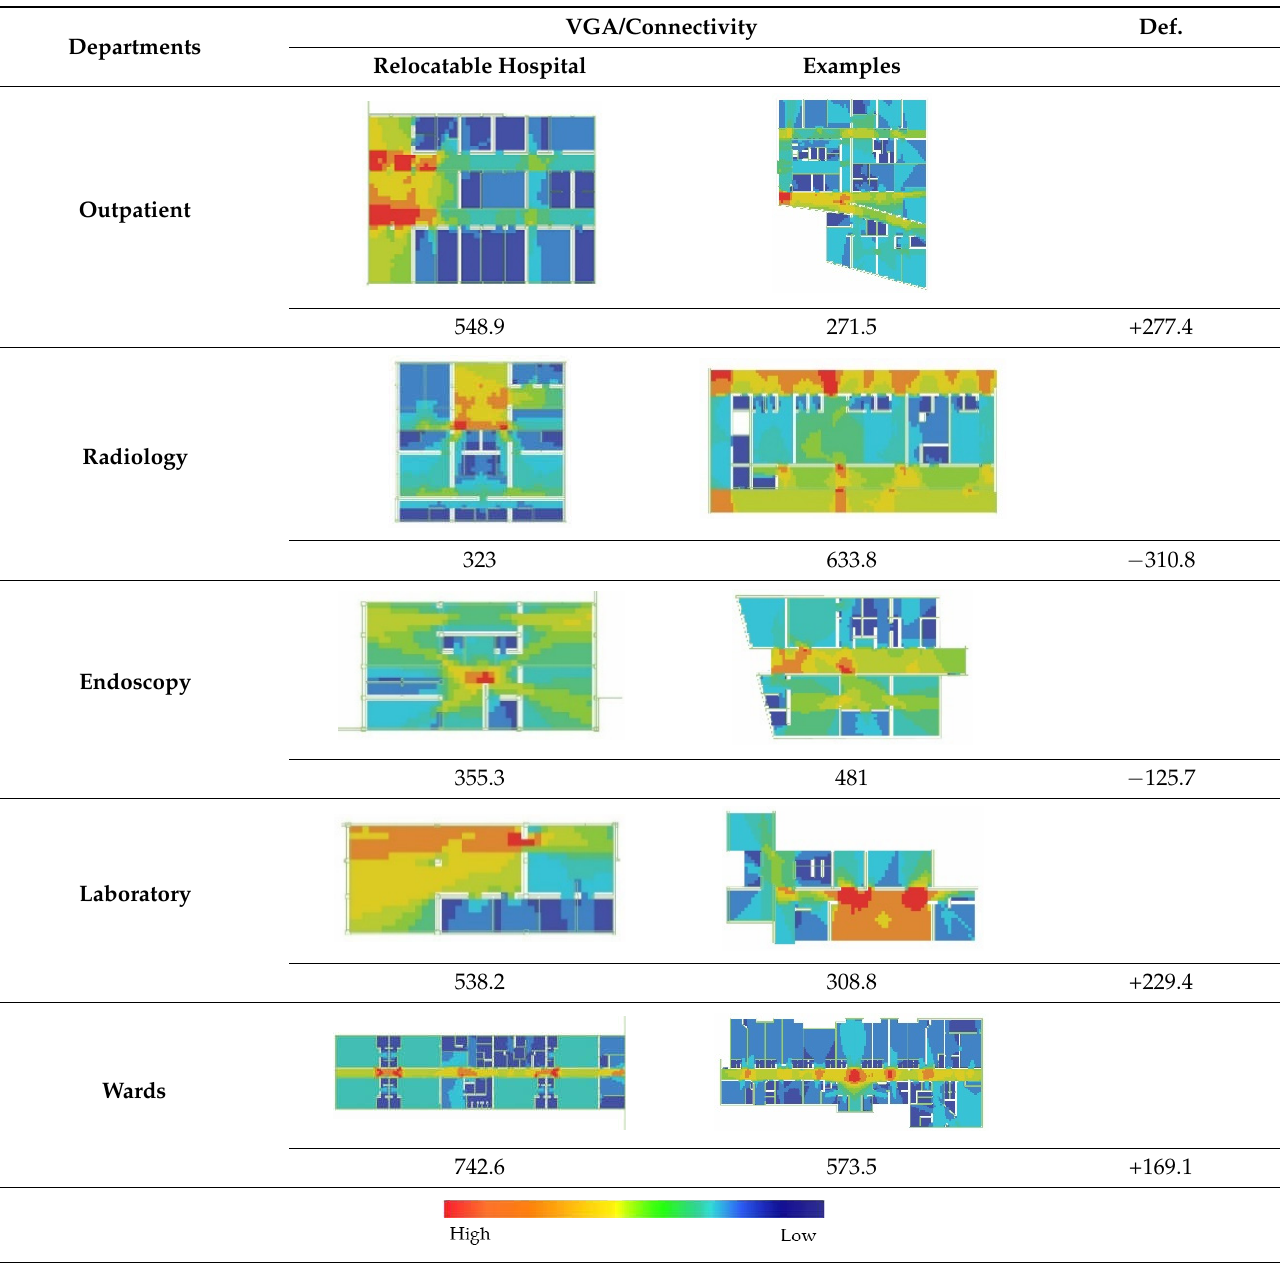
Table 15. Visual graph analysis/integration values and graphs of case study departments com- pared to examples.